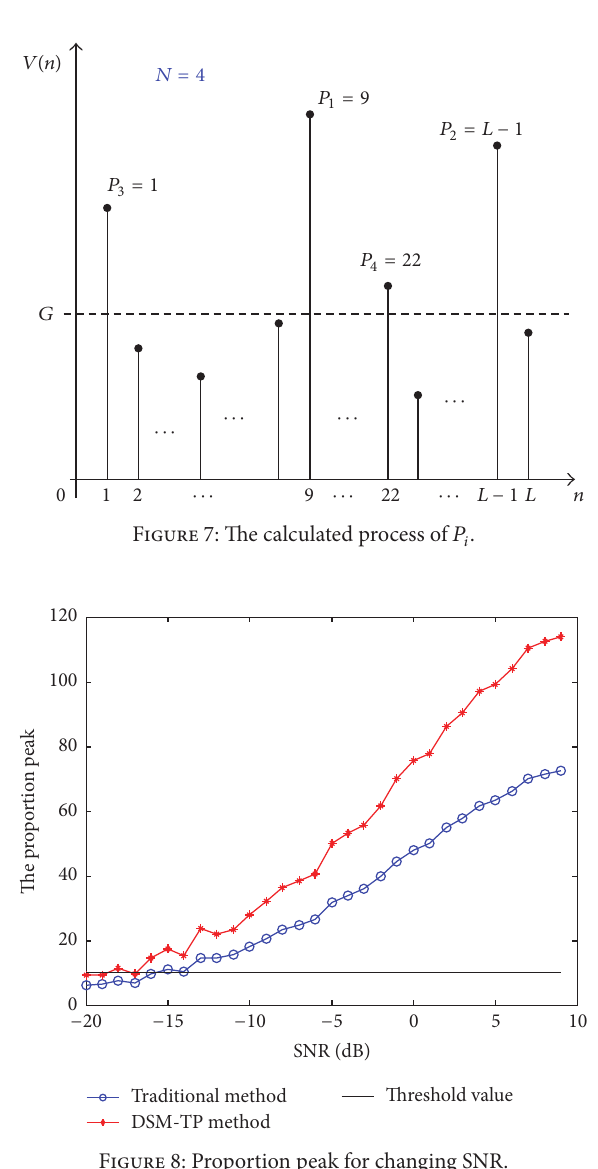
Figure 8: Proportion peak for changing SNR.